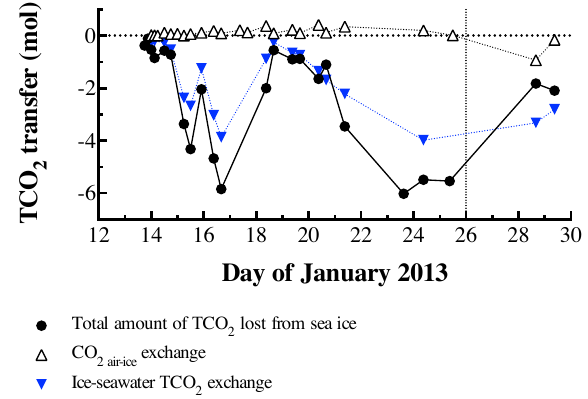
Figure 9. Total amount of TCO 2 lost from the ice cover (black dots), amount of CO 2 exchange between the atmosphere and the ice cover (CO 2air − ice , white triangle) and sea ice–seawater TCO 2 ex- changes (blue triangle) measured in moles for each day, integrated over the whole tank. The dotted line on 26 January marks when the heat was turned back